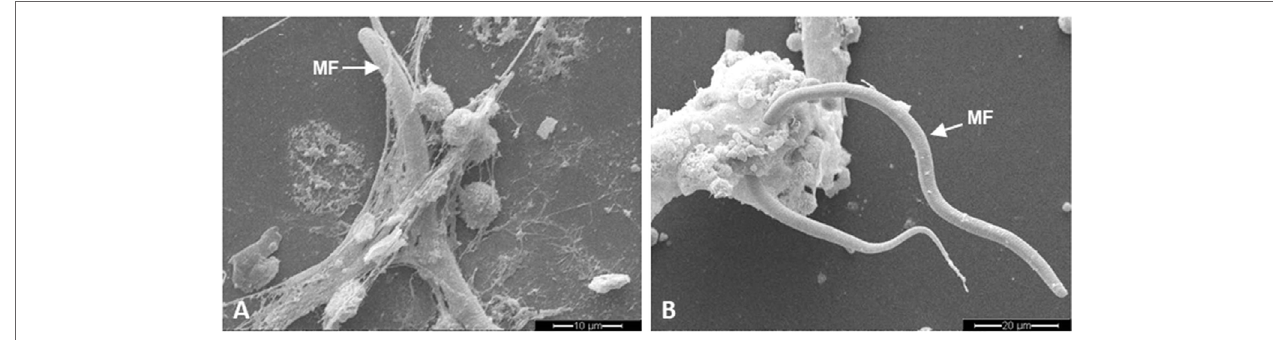
FigUre 1 | Dirofilaria immitis -induced neutrophil extracellular trap (NET) formation analyzed via scanning electron microscopy analysis. Coculture of canine polymorphonuclear neutrophils with D. immitis microfilariae (MF). (a) Fine spread NETs entrapping microfilariae. (B) Meshwork of aggregated NETs ( agg NETs) entrapping